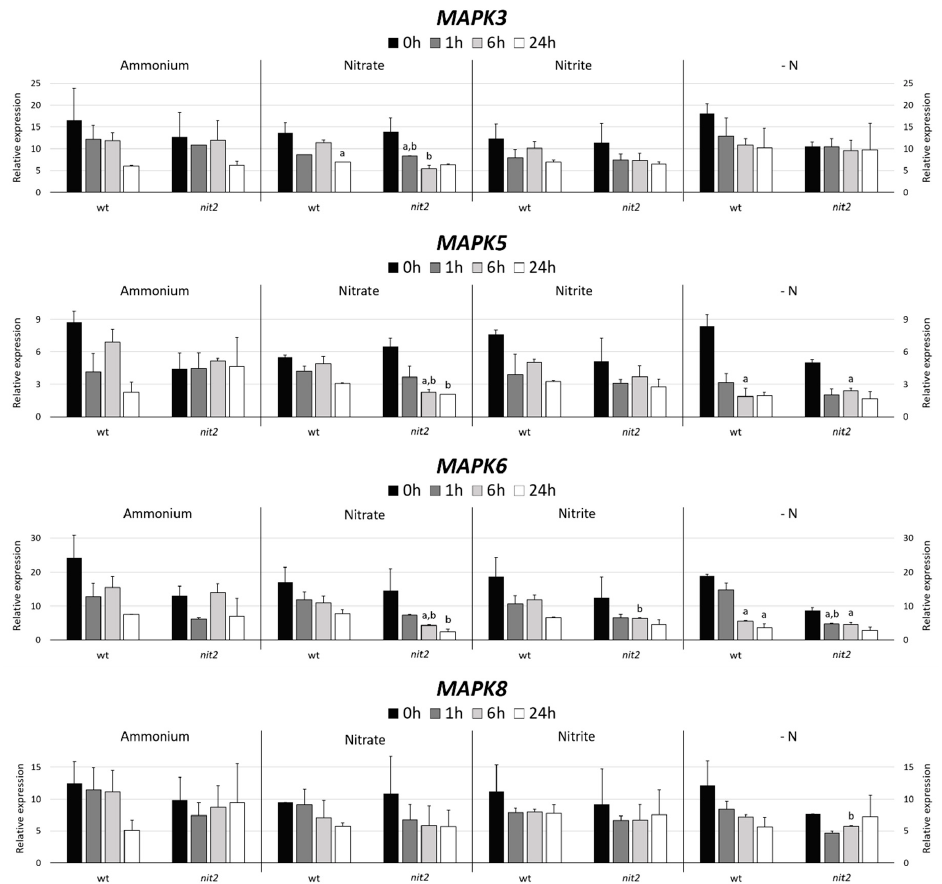
Figure 4. MAPK gene expression. The gene expression of Chlamydomonas MAPK3 , MAPK5 , MAPK6 and MAPK8 were studied in the wt (704) and nit2 (89.87) at di ff erent times, in medium without nitrogen (-N) and with ammonium (8 mM), nitrate (4 mM), or nitrite (2 mM). The gene expression was quantified by RT-qPCR, the value 0 was assigned to the expression level of internal standard gene ubiquitine ligase in each condition. Error bars indicate the standard deviation of three biological replicates. Comparisons were made by the Student’s t -test. (a) Indicates statistical di ff erences ( p < 0.05) compared to ammonium medium in the same strain and (b) compared to the wt strain in the same medium (see Materials and Methods section for further